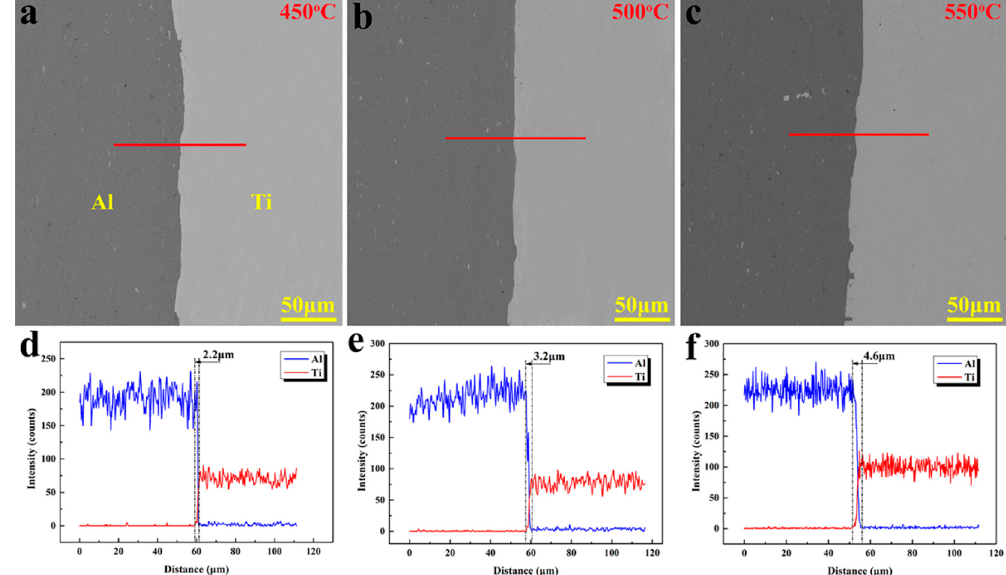
Figure 3. SEM image and element line scan in the bonding interface of Al/Ti LMCs after diffusion process: ( a , d ) 450 °C; ( b , e ) 500 °C; ( c , f ) 550 °C.